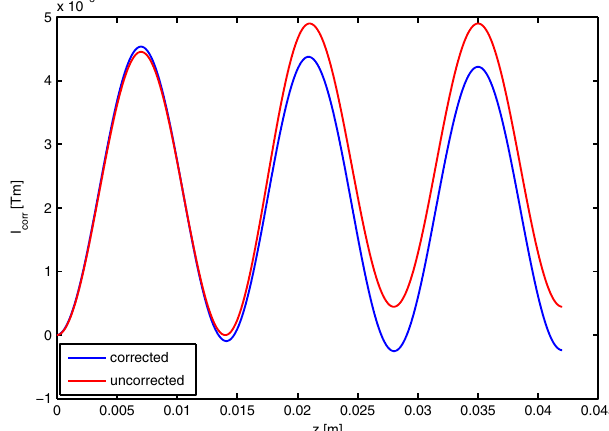
FIG. 7. (Color) Comparison of the first field integral along the beam axis with (blue) and without (red) induction shimming.